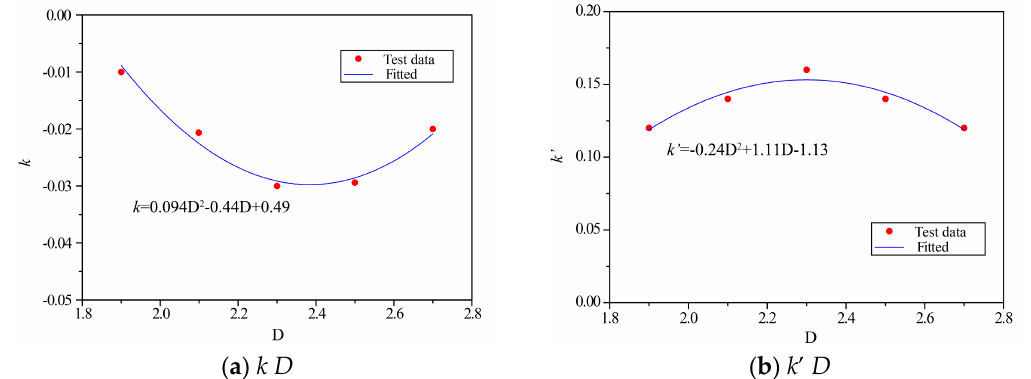
Figure 16. Fitting the material constants k and k ’ with a quadratic polynomial function of fractal dimension D.